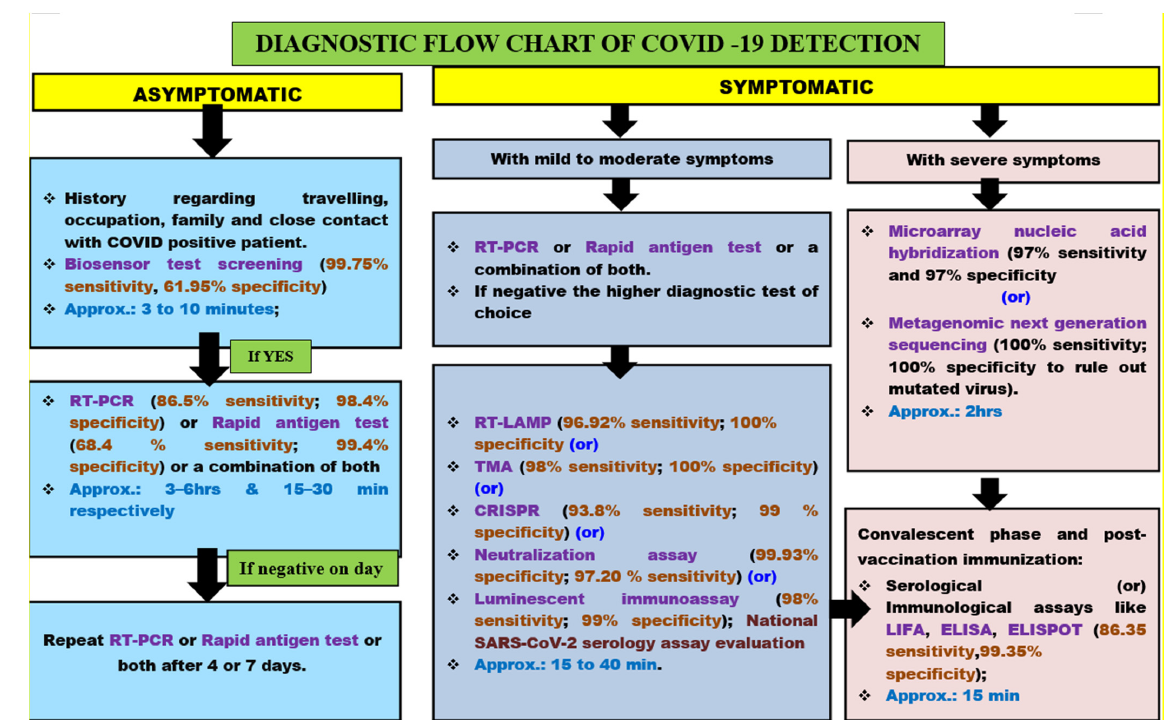
Figure 6. Diagnostic flow chart for COVID-19 disease detection.The probable flow chart used to rule out positive or negative test results forSARS-CoV-2infections in asymptomatic and symptomatic individuals with COVID-19 [103–113].